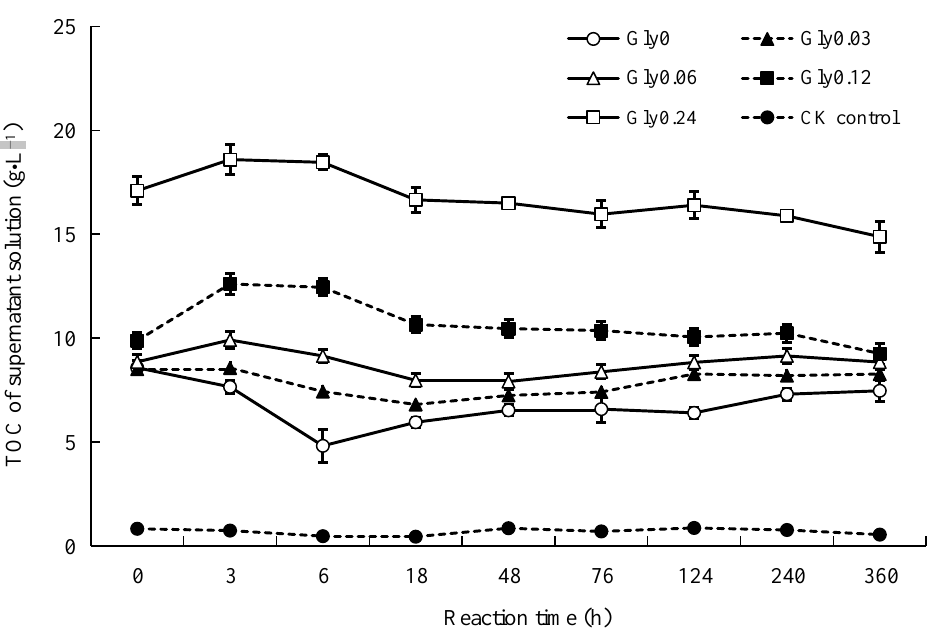
Figure 2. Effects of the glycine with different concentrations in the Maillard precursors on the TOC of the supernatant